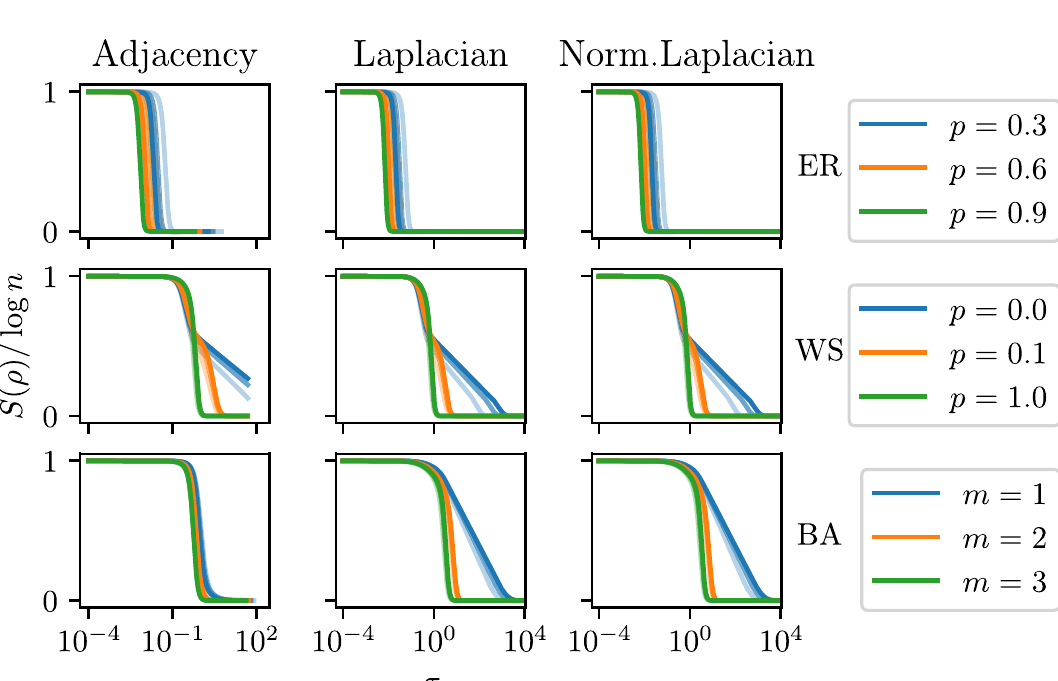
Figure 2. Illustration of the entropy’s phase transition for the ER, WS and BA models and all considered graph matrices. The value of the entropy is normalized by dividing by log n . The dimension is n = 1200 . For WS we choose parameters K = 4 and β = 0.6 . The specific model parameters are stated in the corresponding legends. Each plot is obtained by averaging 100 randomly sampled graphs. The transparency in the plot denotes the size of the subgraph of the originally sampled random graph. In increasing order of opacity, these lines correspond to 33%, 66% and 100% of the total number of nodes of the sampled graph chosen for calculations. Subgraphs were generated by choosing a vertex with the highest degree, and 33% and 66% vertices nearest to